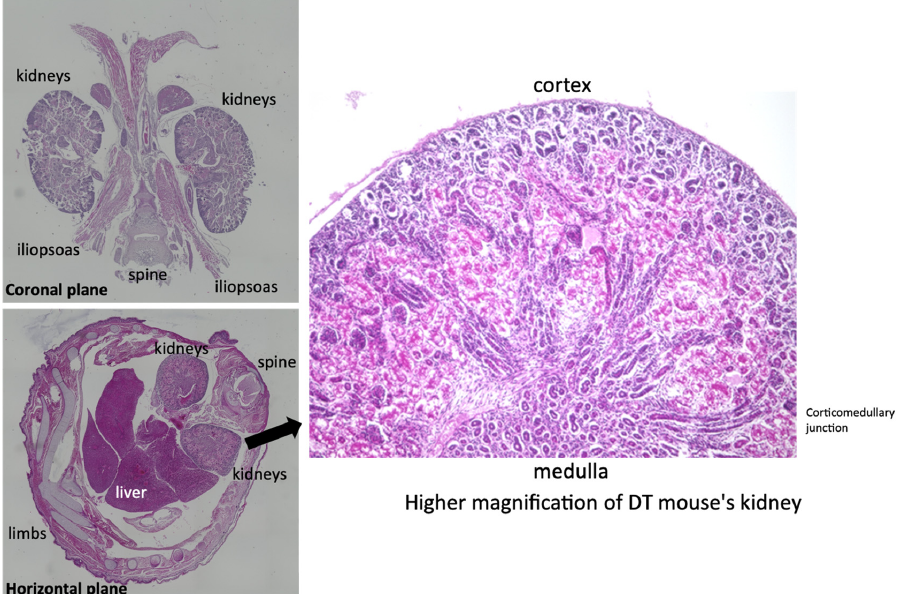
Figure 11. Representative histopathological ARen2-TG/(P)RR-TG DT (double transgenic) mice fetuses, by HE staining, at both lower magnifications of coronal plane, horizontal plane, and higher magnifications (X400).